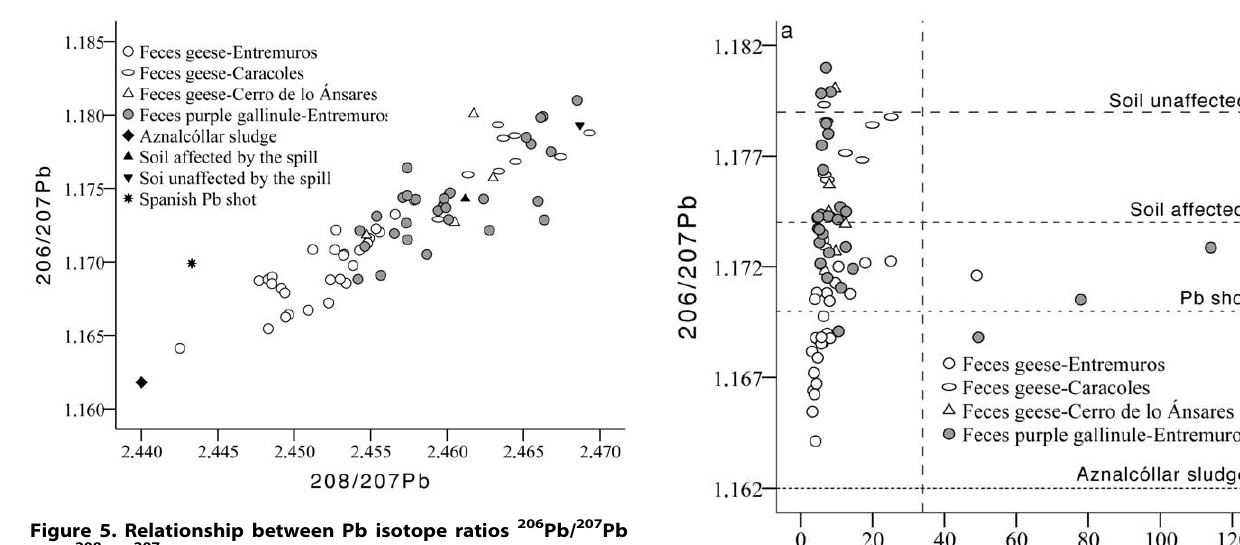
Figure 5. Relationship between Pb isotope ratios 206 Pb/ 207 Pb and 208 Pb/ 207 Pb in feces. Additionally, the figure shows mean Pb isotopic ratios described for the Aznalco´llar sludge, for Entremuros sediment affected by the spill, for unaffected sediment adjacent to the Entremuros [23], and for Spanish Pb shot [31].